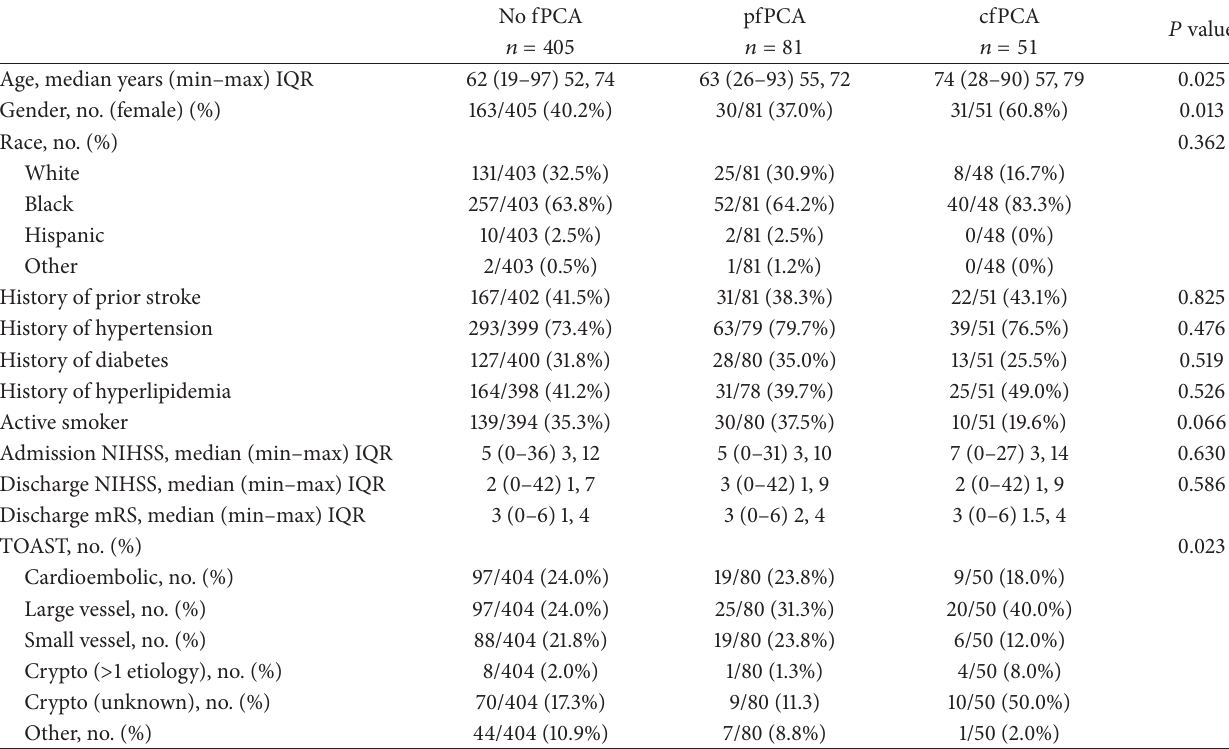
Table 1: Demographics, vascular risk factors, and outcome in patients without fetal PCA (no fPCA), partial fetal PCA (pfPCA), and complete fetal PCA